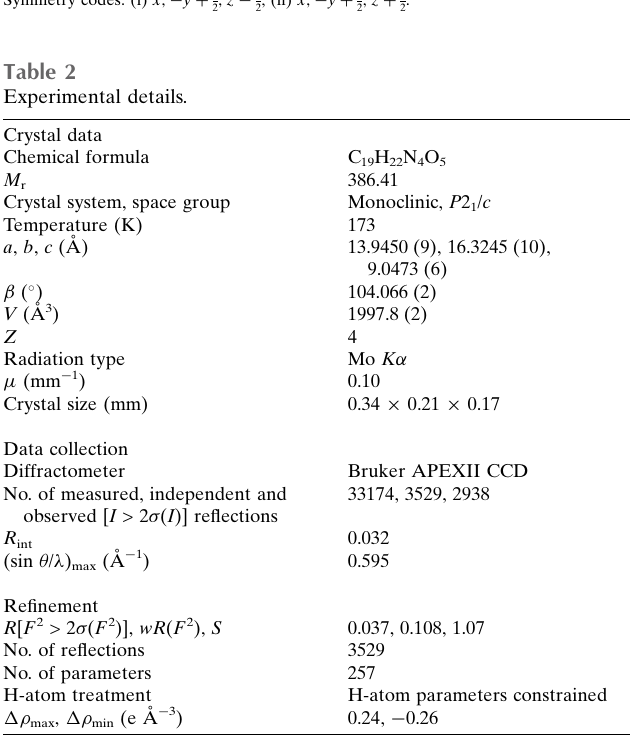
Table 2 Experimental details.